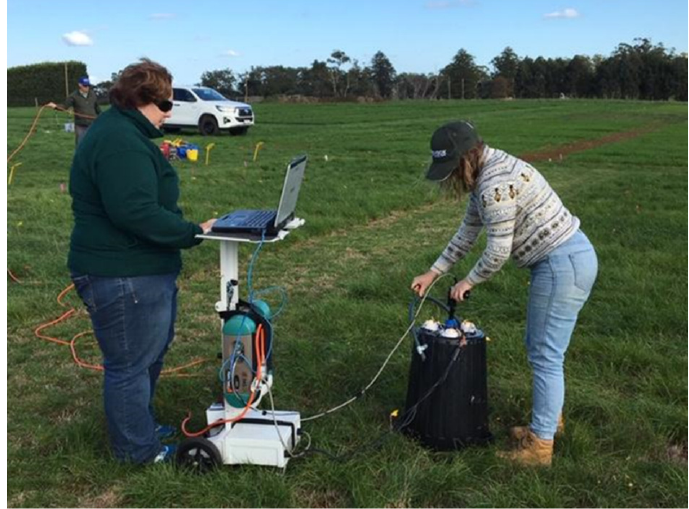
Figure 1. The FieldSpec ® HiRes 4 is mobilised using an ASD field-lab 2019, and the sensor is fitted into a holder within a light shield to capture canopy spectra under stable light conditions.